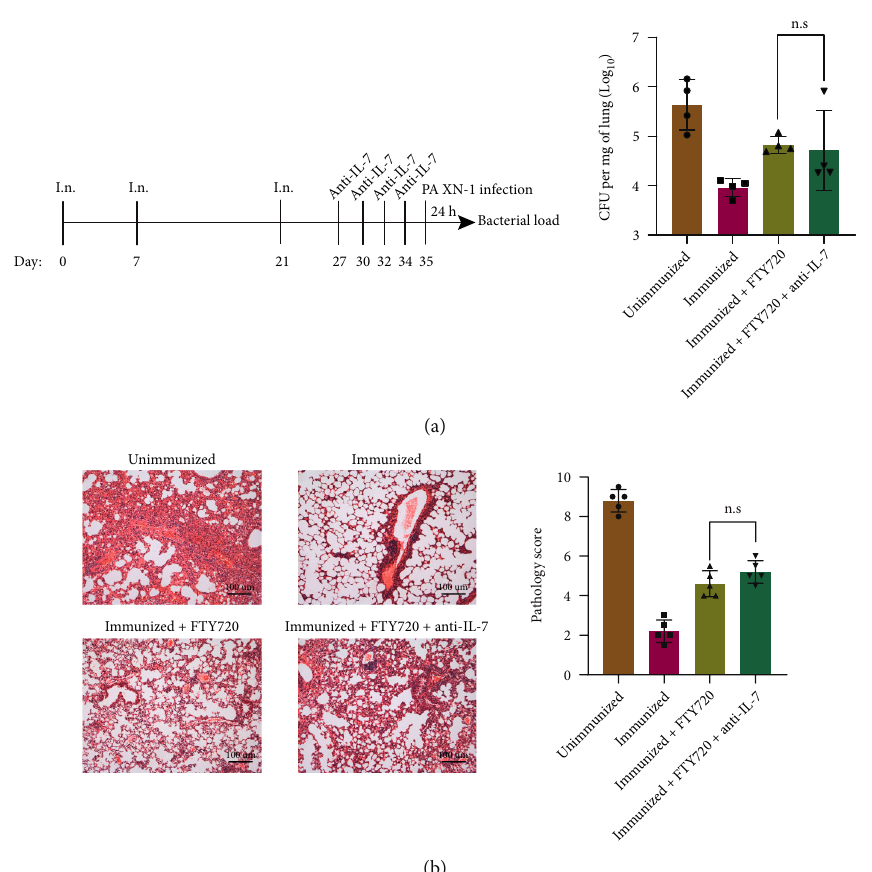
Figure 6: rePcrV vaccine e ffi cacy remains independent of IL-7. (a) Experimental timeline. Lung CFU 24 hours after infection in naïve mice, rePcrV-immunized mice, and FTY720 treatment-immunized mice with or without anti-IL-7 Ab ( n = 4 ). (b) Representative H and E stains in naïve mice, rePcrV-immunized mice, and FTY720 treatment-immunized mice with or without anti-IL-7 Ab ( n = 5 ). Signi fi cant di ff erences were calculated using unpaired t -test. The “ n.s. ” means “ no signi fi cant di ff erence.